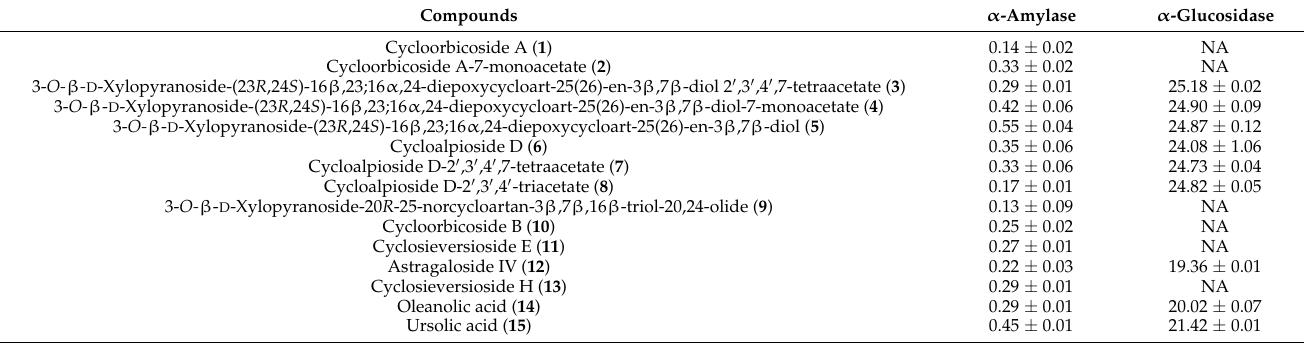
Table 2. α -Amylase and α -glucosidase inhibitory activity of fifteen triterpenes expressed in mmol ACAE/g.